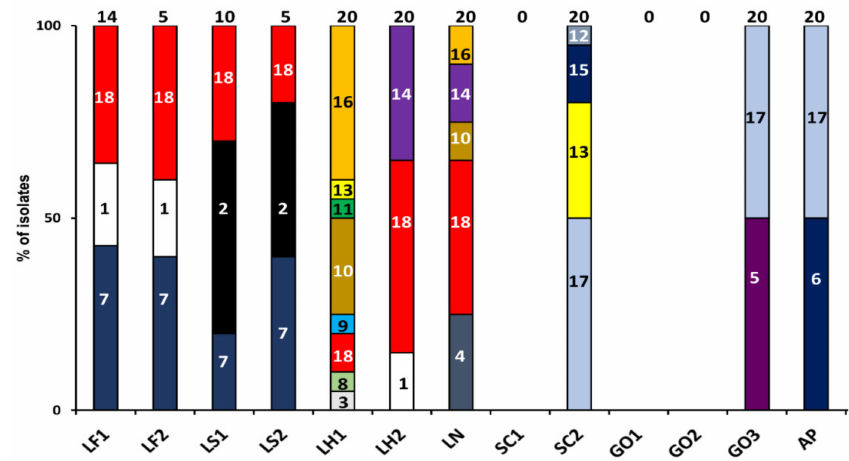
Figure 2. Culture-dependent microbial community dynamics and identifications of starter culture-initiated sourdough productions after 72 h of fermentation. The indication of the starter culture strains is as in Table 1. The total number of isolates identified is indicated on top of the bars. The numbers in the bars correspond with the following identities for the 16S rRNA gene: 1, Limosilactobacillus fermentum (100% identity; accession no. LC065036.1); 2, Latilactobacillus sakei